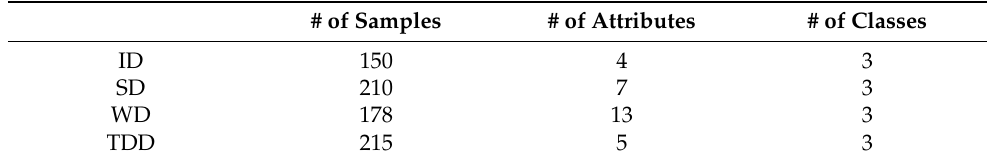
Table 4. Parameters of four real-world datasets. # of Samples # of Attributes # of Classes ID